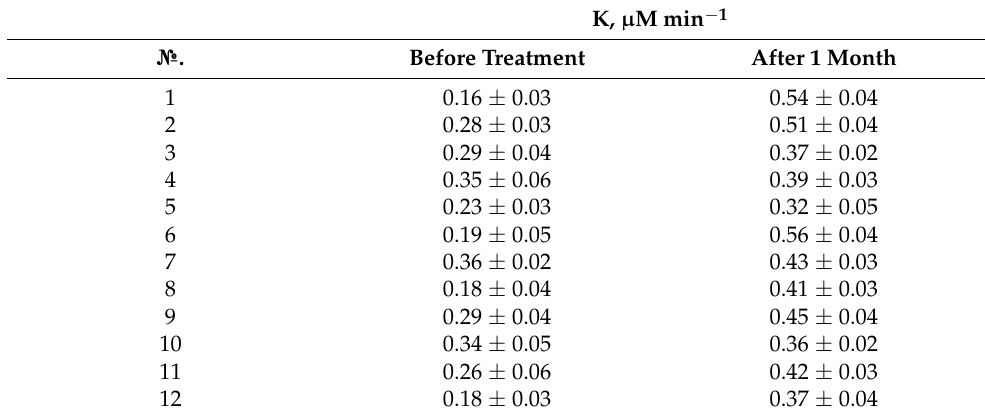
Table 4. The values of the total activity of antioxidants in the blood serum of patients diagnosed with chronic cerebral ischemia ( p = 0.95, n = 3) treated with Cytoflavin. K, µ M min − 1 № . Before Treatment After 1 Month 1 0.16 ± 0.03